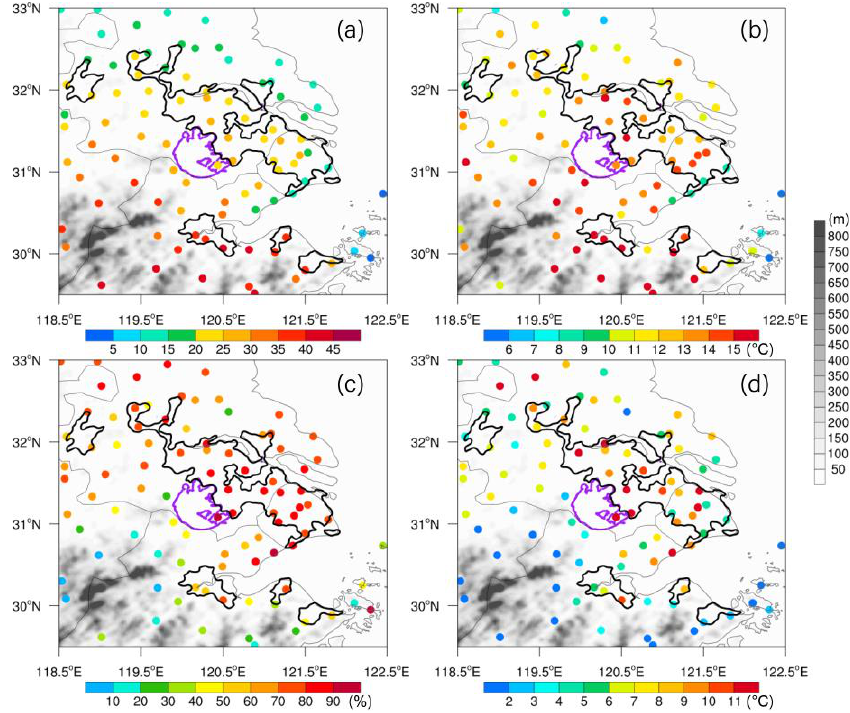
Figure 2. Spatial distribution of EHEs occurred over the YRD region in the warm seasons during 2008 – 2017. ( a ) Occurrence frequency of heatwaves. ( b ) Average cumulative intensity of heatwaves. ( c ) Proportion of warm nights in heatwaves. ( d ) Average cumulative intensity of warm nights. Gray shadings denote the topography. Black lines indicate the urban regions, and thin gray lines denote the provincial boundaries and coastlines. Purple lines show Lake Taihu.